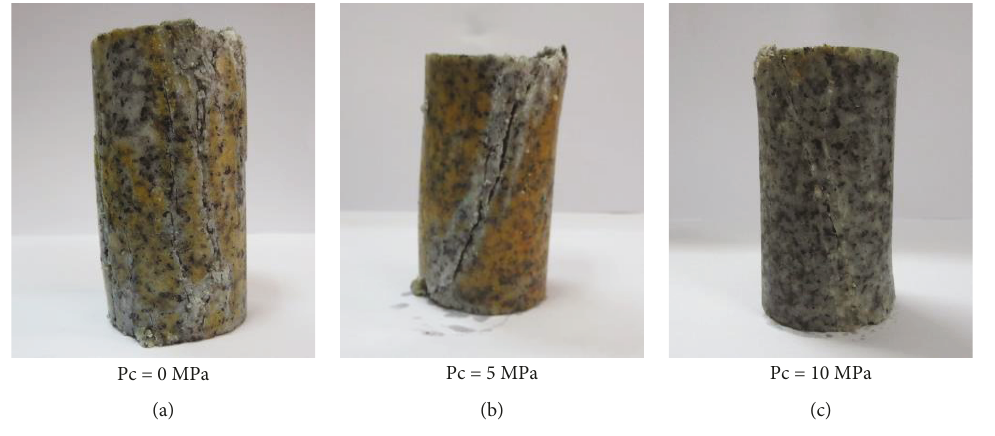
Figure 2: Crack patterns after failure.